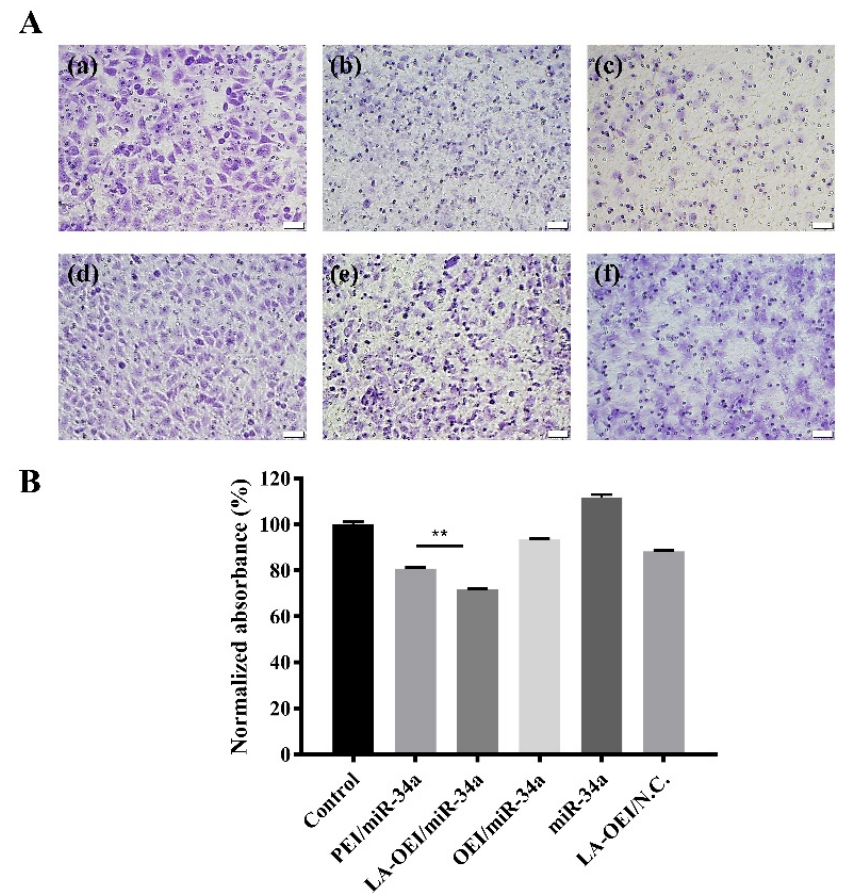
Figure 9. The anti-migration effect of HeLa cells after the miR-34a transfection using Transwell migration assay. ( A ) The staining with 0.1% crystal violet for the cells which have migrated to the lower surface of membrane: ( a ) control, ( b ) PEI/miR-34a, ( c ) LA-OEI/miR-34a, ( d ) OEI/miR-34a, ( e ) miR-34a and ( f ) LA-OEI/N.C. The scale bar is 50 µ m. ( B ) Quantitative analysis of the cells which have migrated to the lower surface of membrane. Data were presented as the mean value ± SD of triplicate experiments (** p <